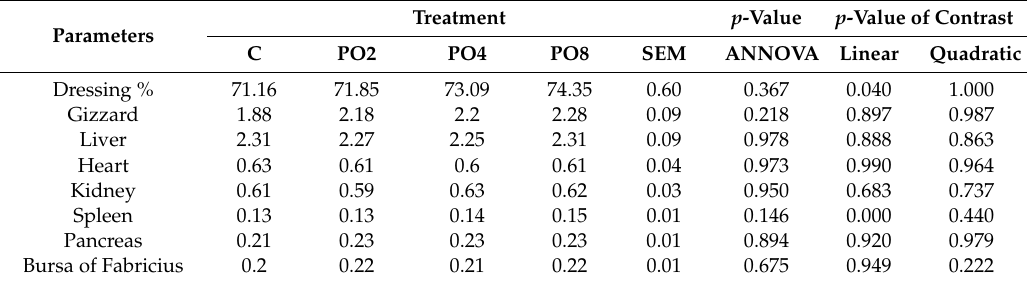
Table 7. Dressing percentages and relative internal organs weights of broilers fed di ff erent supplementation doses of POLM at day 42. Parameters